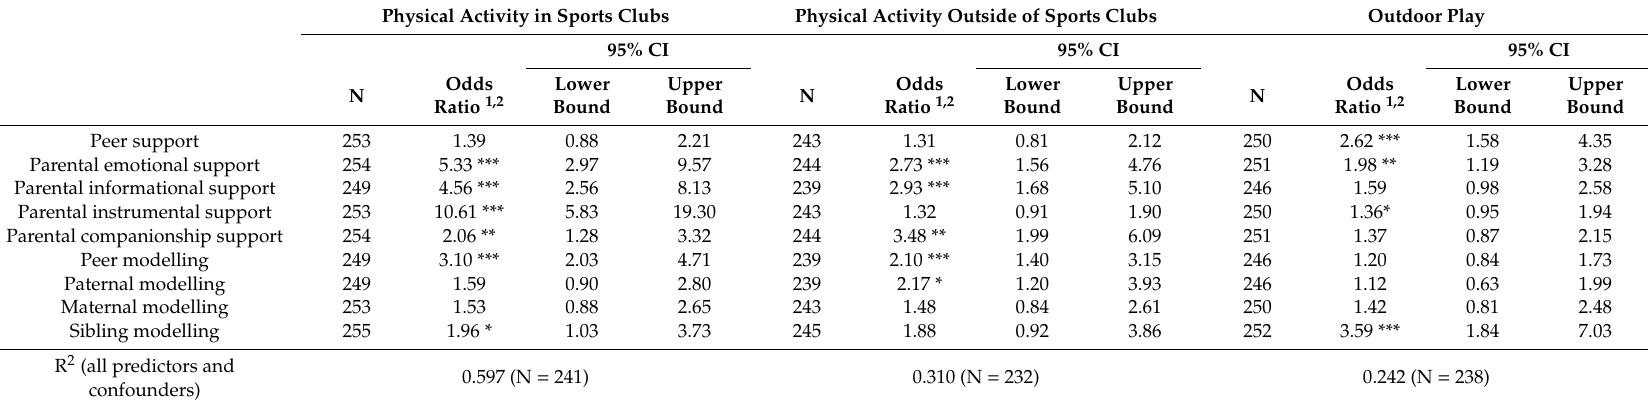
Table 3. Results of the logistic regression analysis of social support and physical activity in di ff erent domains in boys aged 4–6. Physical Activity in Sports Clubs Physical Activity Outside of Sports Clubs